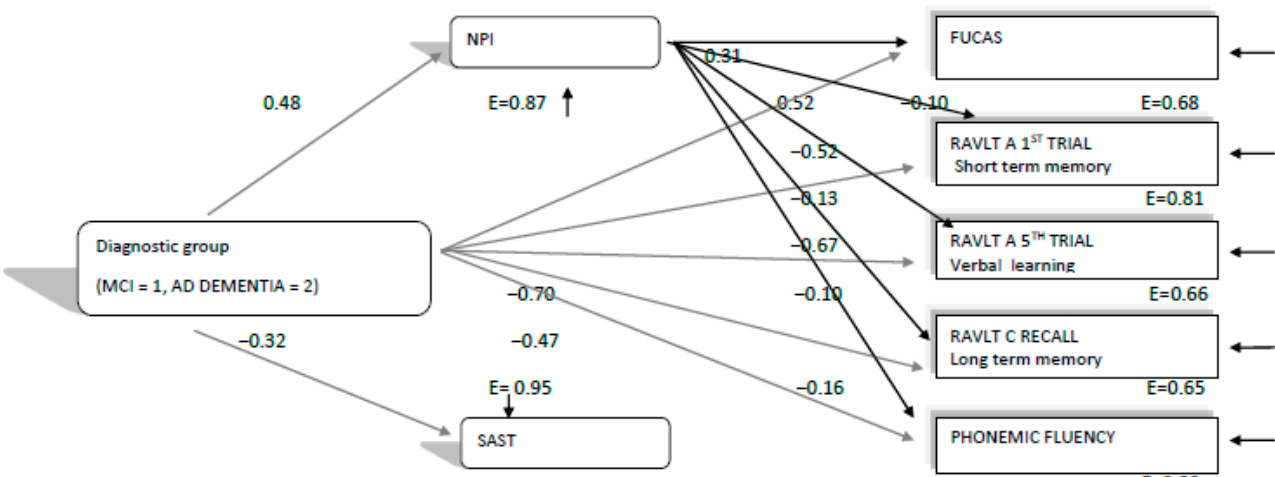
Figure 2. Direct and indirect relationships of diagnostic group (MCI, ADD) and negative affect (NPI, SAST) variables with everyday functioning and cognitive variables, which were found to decline faster between the 2019 and 2020 measurements than between 2018 and 2019, as measured in 2019 neuropsychological assessment. All relationships are significant at the p < 0.05 level. E = measurement error. All everyday functioning and cognitive variables were found to correlate significantly ( p < 0.05) between each other.